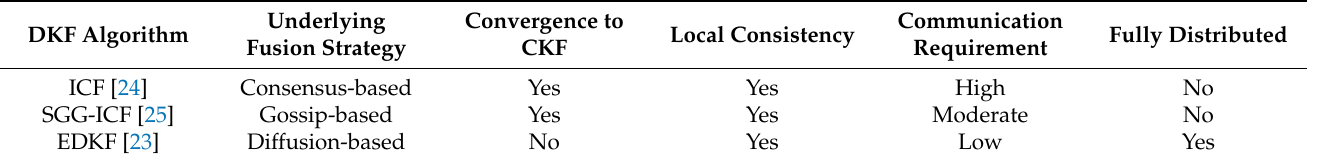
Table 1. Comparison of selected DKF algorithms. DKF